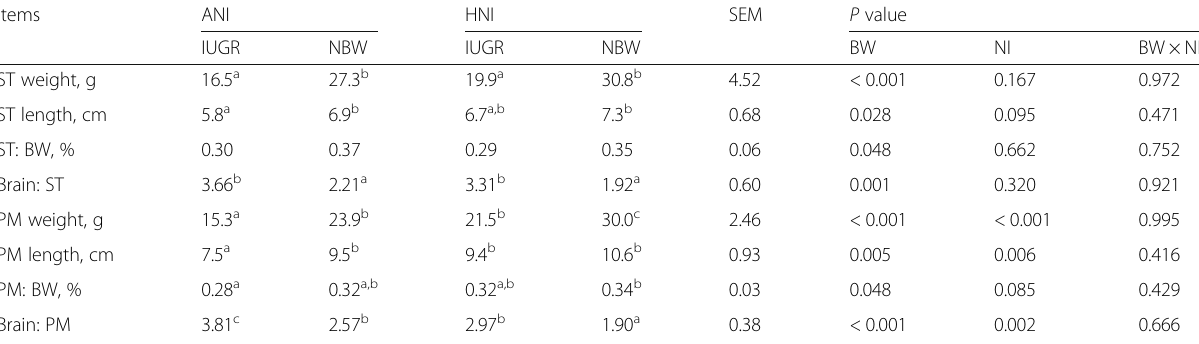
Muscle characteristics Table 3 Effects of the level of nutrient intake on the muscle weights and lengths, muscle to body weight ratios, and brain to muscle ratios of intrauterine growth-restricted (IUGR) and normal birth weight (NBW)